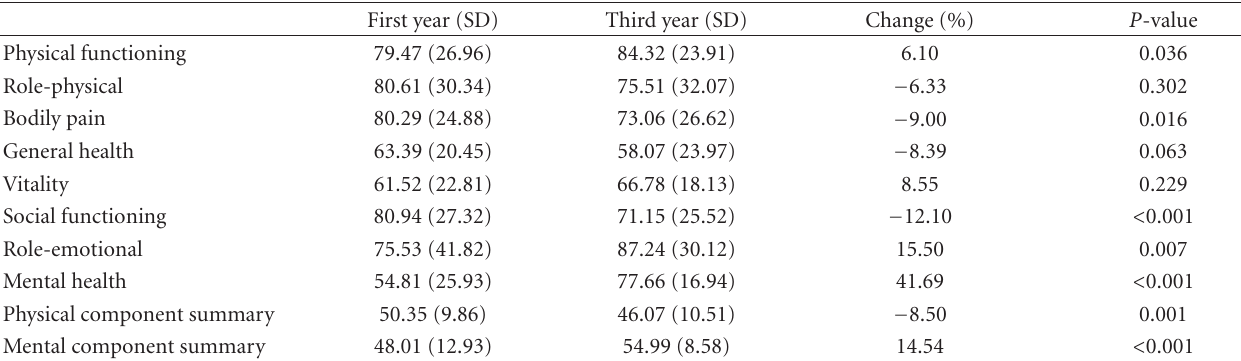
Table 2: Comparison of the HRQoL scores at the first and third year post-treatment.